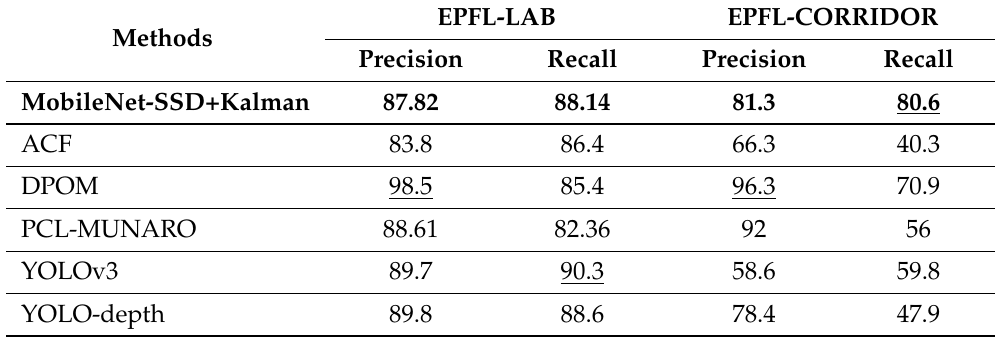
Figure 11. Recall–precision curves for different environments in EPFL dataset. Table 3. Recall and precision of EPFL dataset.